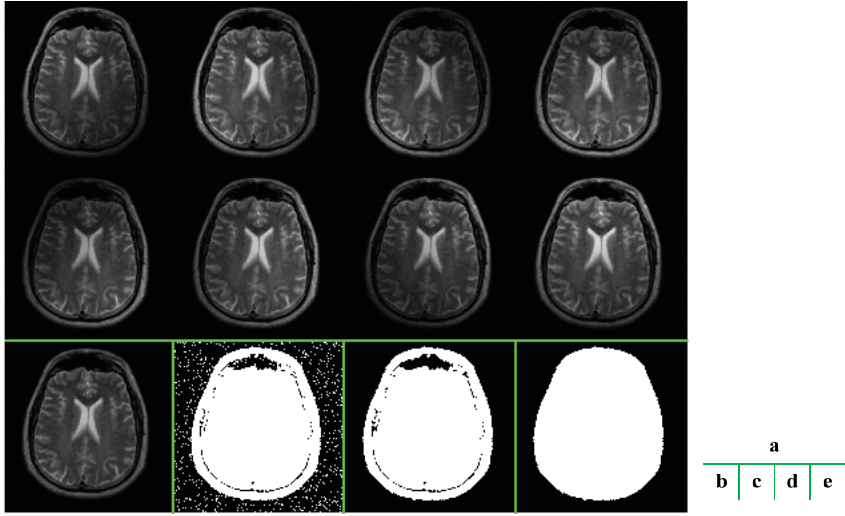
Figure 3. Illustration of obtaining ROS: ( a ) eight Scout images; ( b ) the summation of the squares of the magnitudes of eight scout images; ( c ) Support area, use 1% of maximum intensity as the threshold; followed by two morphological operations: ( d ) ROS after opening Procedures; ( e ) ROS after filling